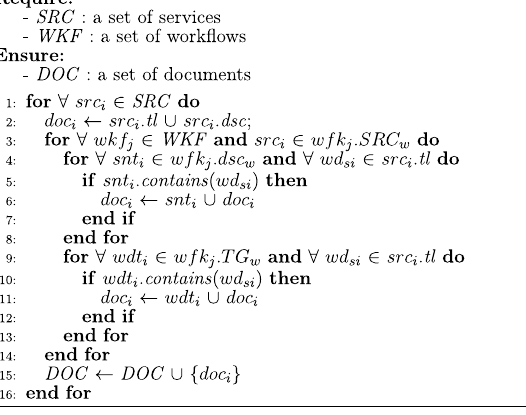
Algorithm 1. Service corpus construction